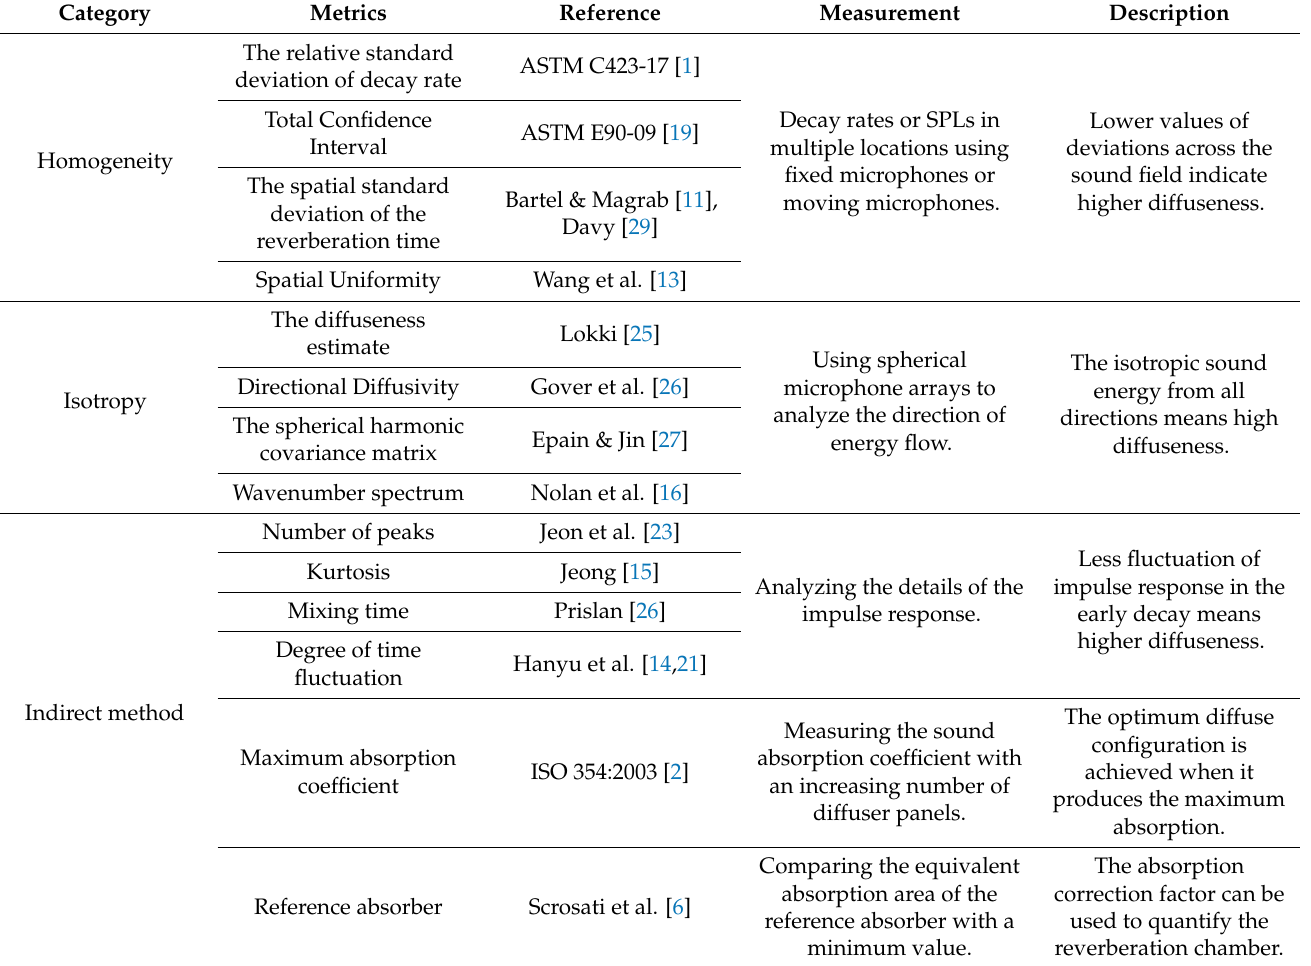
Table 1. Proposed methods for quantifying diffuse conditions of a reverberation